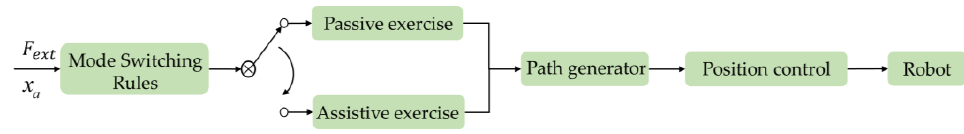
Figure 2. Mode self-switching flow chart.